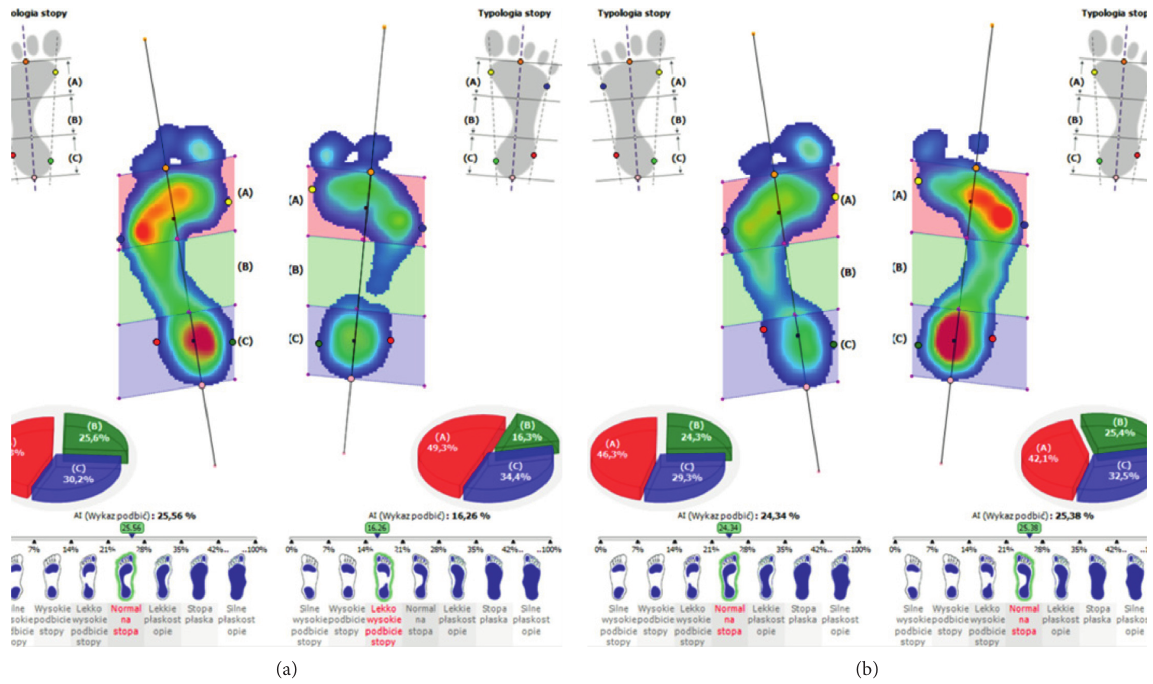
Figure 5: (a) The results of the AI test before repositioning the mandibular head in the articular fossa and stabilizing the position of the condylar process with a temporary silicone occlusal splint, in an exemplary patient. (b) The results of the AI test after repositioning the mandibular head in the articular fossa and stabilizing the position of the condylar process with a temporary silicone occlusal splint, in an exemplary patient.